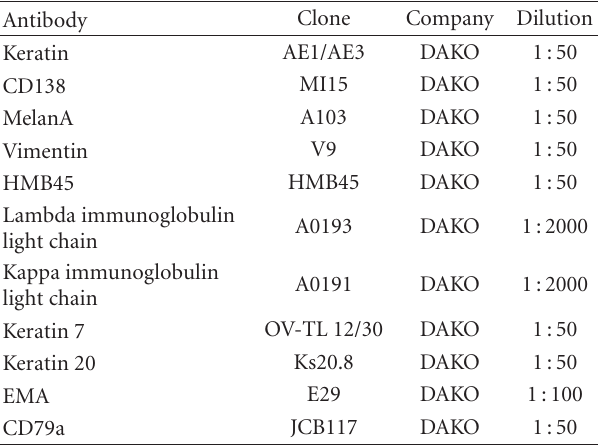
Table 1: Panel of immunohistochemical